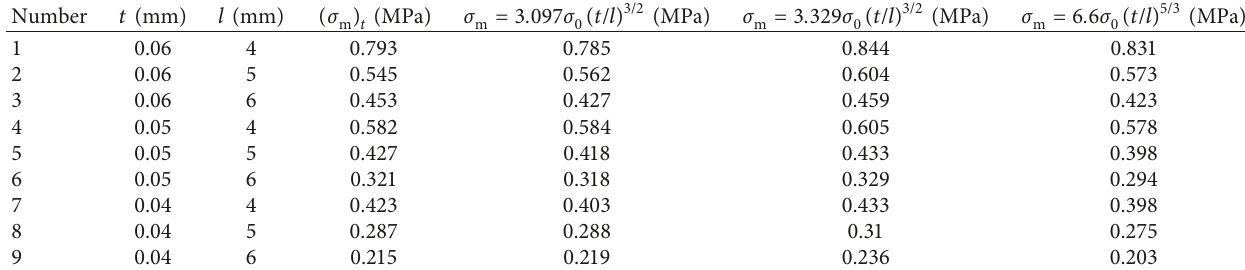
Table 2: Comparison and analysis of theoretical models for mean stress.